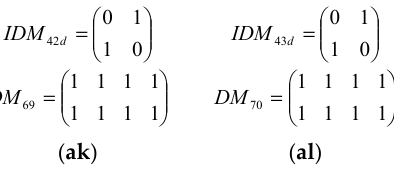
Figure A2. Combinatorial reasoning mechanism with topological and metric relations between the SGRPMs. ( a )–( al ) depict 38 typical relations between two DSL-SRMs that express only one typical topological relations between regions.